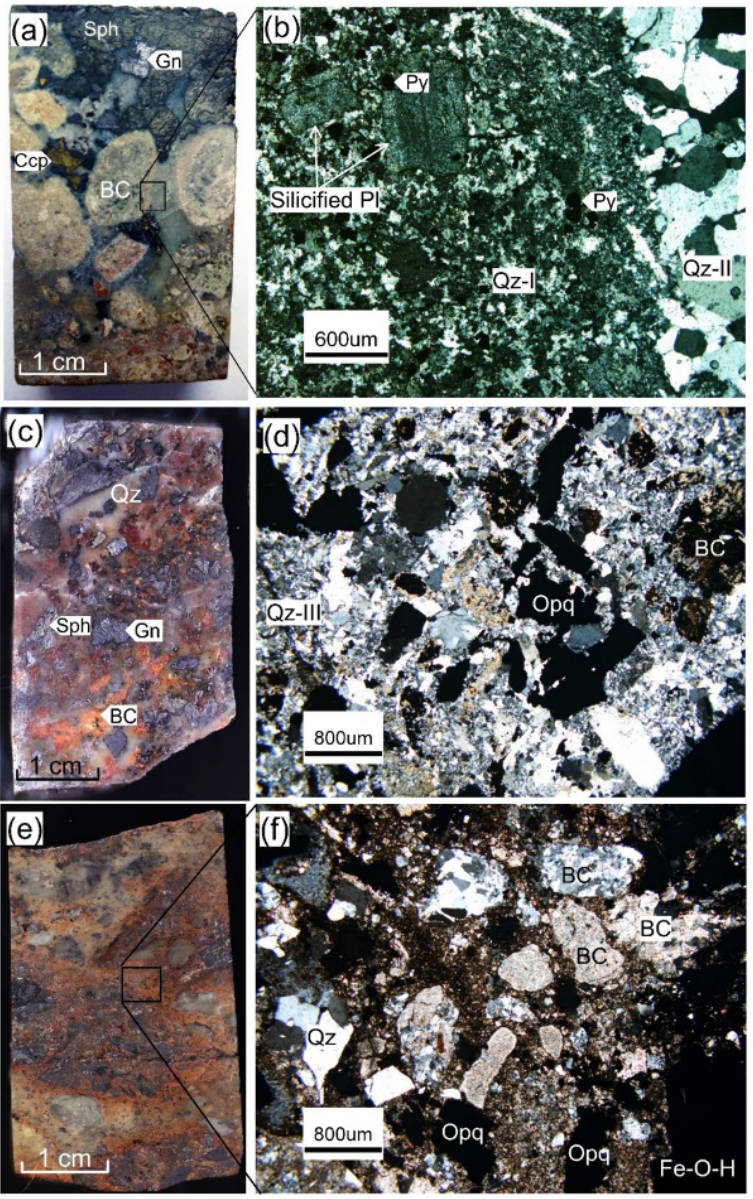
Figure 11. Representative photographs and photomicrographs of the different breccias in the Shah-Ali-Beiglou deposit (photomicrographs taken under transmitted cross-polarized light images). ( a ) Breccia-I with rounded clasts in quartz-sulfide cement; ( b ) Pyrite with dessiminated texture in clasts of Breccia-I; ( c ) Hand specimens of breccia-II with angular clasts in quartz-sulfide cement; ( d ) Ore minerals in silica cement occurring as breccia clast; ( e ) Hand specimens of breccia-III; ( f ) Breccia-III with rounded to subrounded clasts in carbonate (-Fe-Oxide) cement. (Gn: